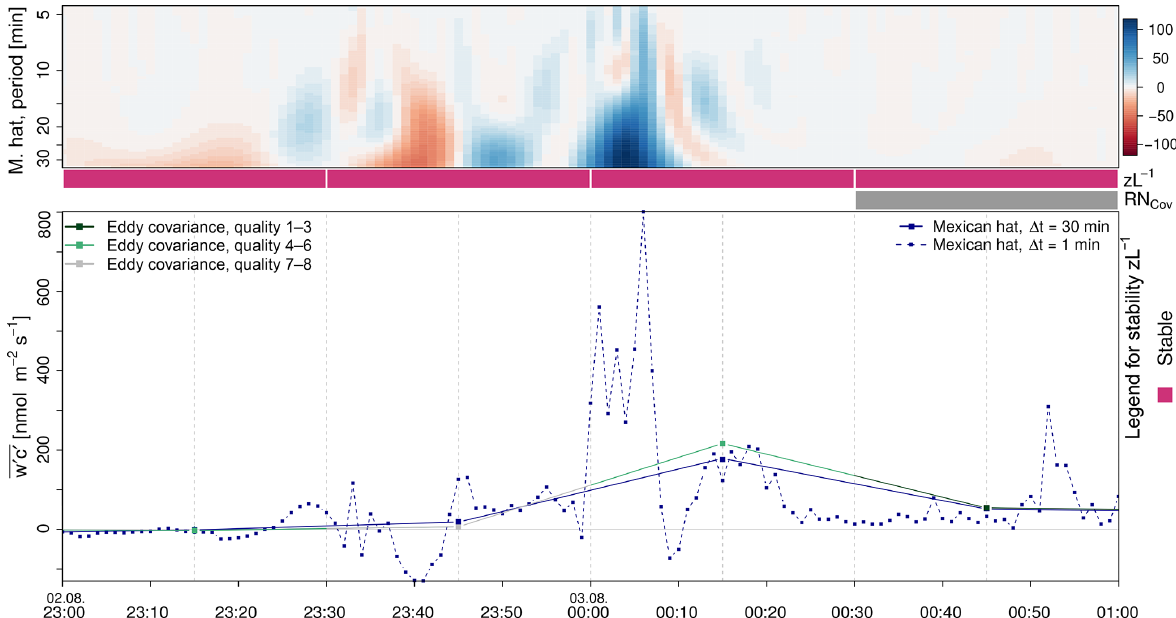
Figure 4. Wavelet cross-scalogram and flux rates computed for tower 2 during the case study event on 2–3 August 2014. The colours in the wavelet cross-scalogram between w and c denote the flux intensity (wavelet coefficient), where intensive colours indicate higher flux contributions downwards (negative, dark red) or upwards (positive, blue). The whole scalogram is outside the cone of influence (COI). Atmospheric stratification zL − 1 (Foken et al., 2004) for every 30min interval was shown as coloured bars right below the cross-scalogram and stable (pink coloured) during the complete time. Grey-coloured intervals in the line labelled RN Cov refer to best steady-state (RN Cov < 30%) conditions according to Foken et al. (2004). The quality classes 1–9 in the bottom panel for EC refer to the overall flux flagging system after Foken et al. (2004).